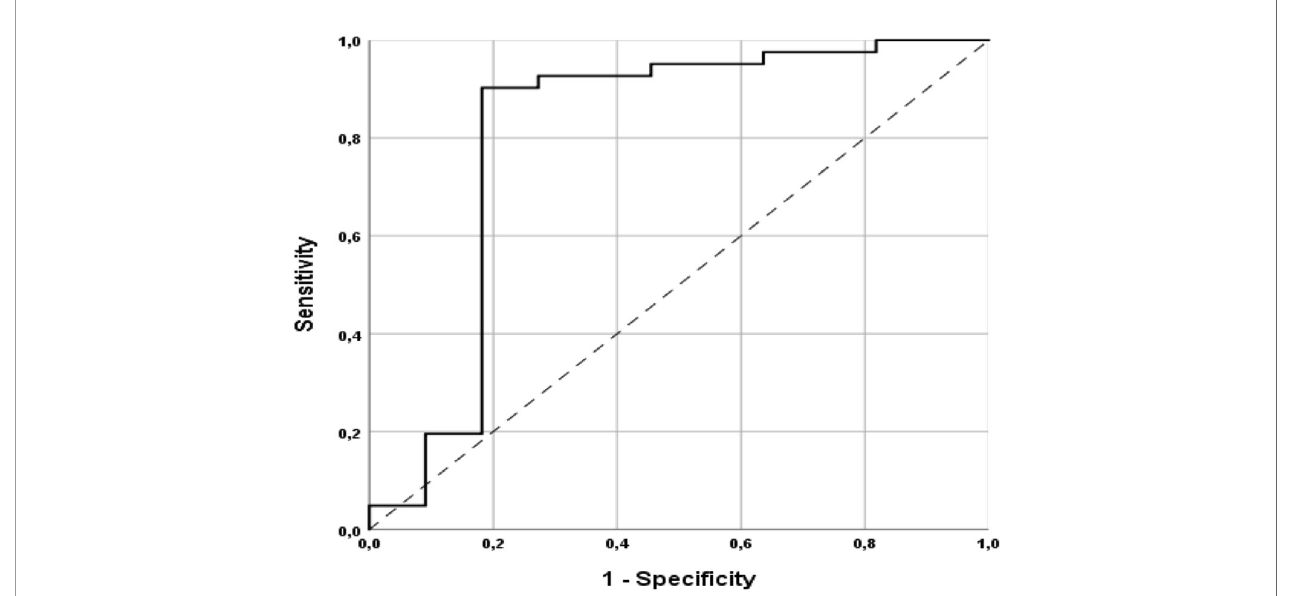
FIGURE 2 | Receiver operating characteristic (ROC) curve of the predicted probability of improvement at W12CAS calculated with binomial logistic regression.